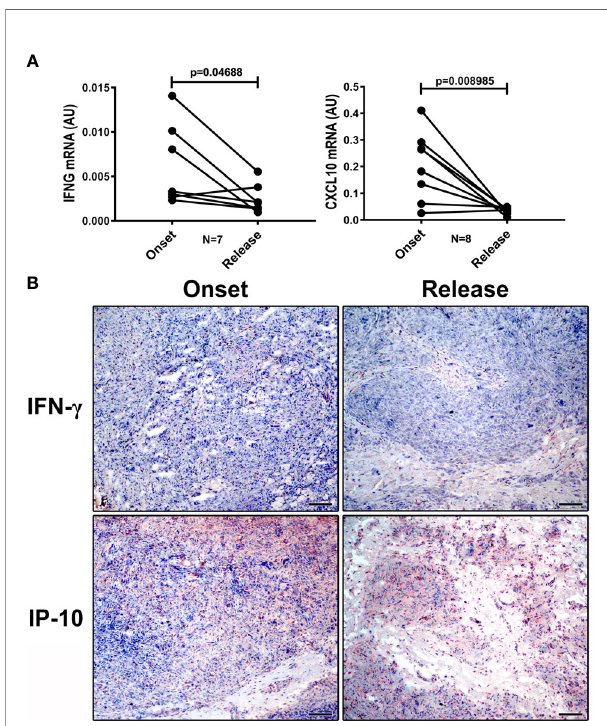
FIGURE 3 | IFN- g and CXCL10 (IP-10) are reduced in LL skin lesions at 12- dose MDT release. Skin lesions fragments were collected at LL diagnosis (onset) and at release of 12-dose MDT: (A) RNA was extracted, cDNA was synthesized and the expression of IFNG and CXCL10 genes was evaluated by real-time PCR. Graphs show the gene expression of each patient at disease onset and 12-dose MDT release. (B) Expression of IFN- g and CXCL10 (IP-10) in the skin lesions was detected by immunohistochemistry. Representative images are shown. Bars: 50 m